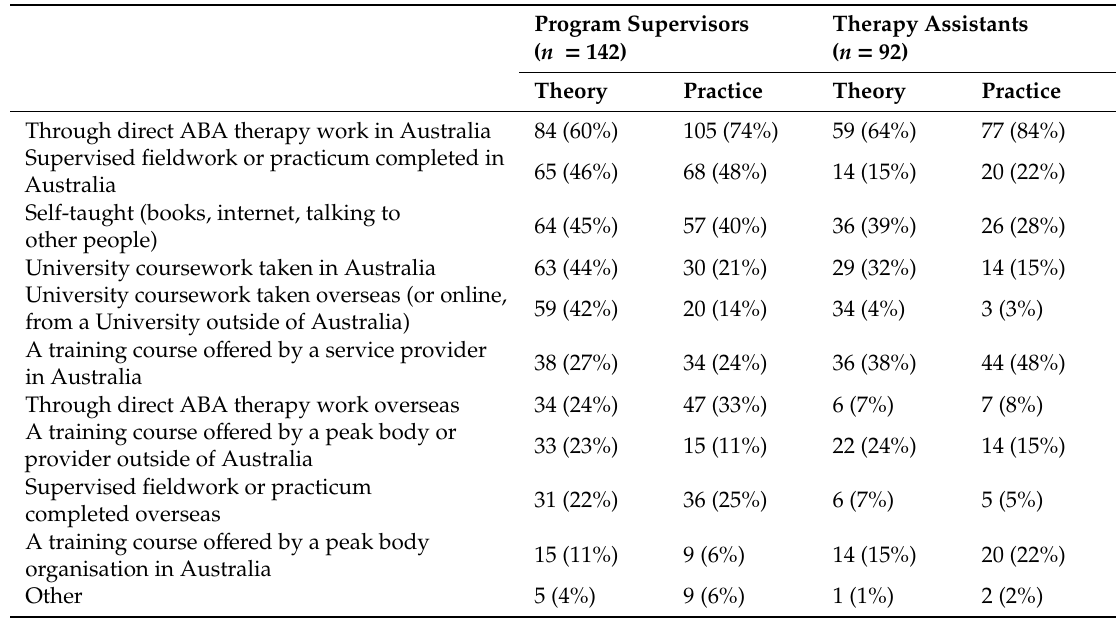
Table 3. Methods of obtaining theoretical and practical training in ABA by Australian program supervisors and therapy assistants.